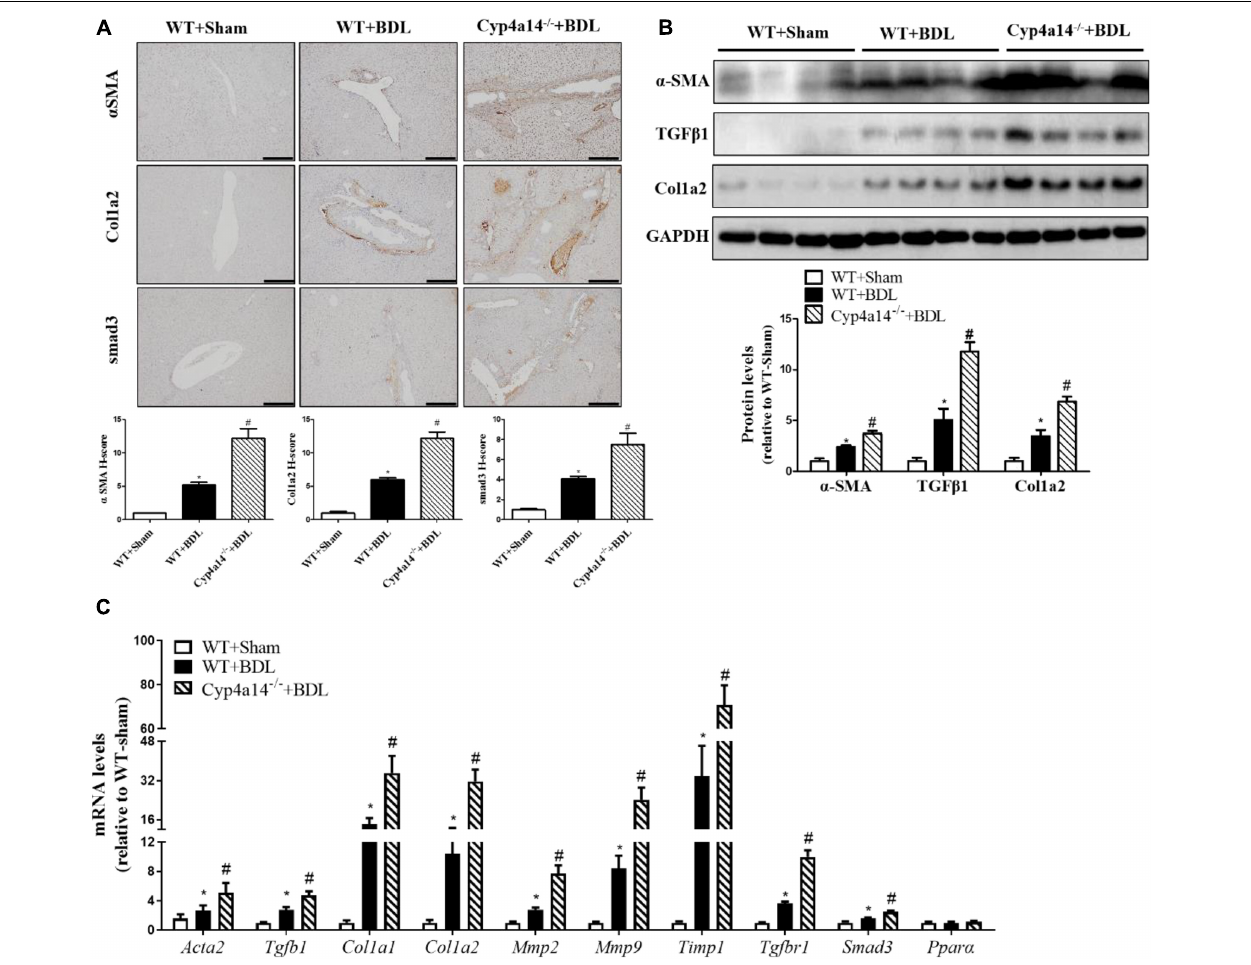
FIGURE 3 | Cyp4a14 ablation enhanced α -smooth muscle actin ( α -SMA), Col1a2, and smad3 expression in bile duct ligation (BDL) mice. (A) Cyp4a14 gene ablation markedly exacerbated BDL-induced α -SMA, Col1a2, and smad3 protein expression in the livers as assessed by an immunostaining analysis. (B) Western blot assay showing the protein levels of α -SMA, TGF- β 1, and Col1a2. (C) Quantitative RT-PCR analysis showing the mRNA levels of Acta2 , Tgfb1 , Col1a1 , Col1a2 , Mmp2 , Mmp9 , Timp1 , TgfbR1 , Smad3 , and Ppar α . n = 6–7. * p < 0.05, WT + Sham and WT + BDL. # p < 0.05, WT + BDL and Cyp4a14 − / − + BDL. Scale bar = 100 µ